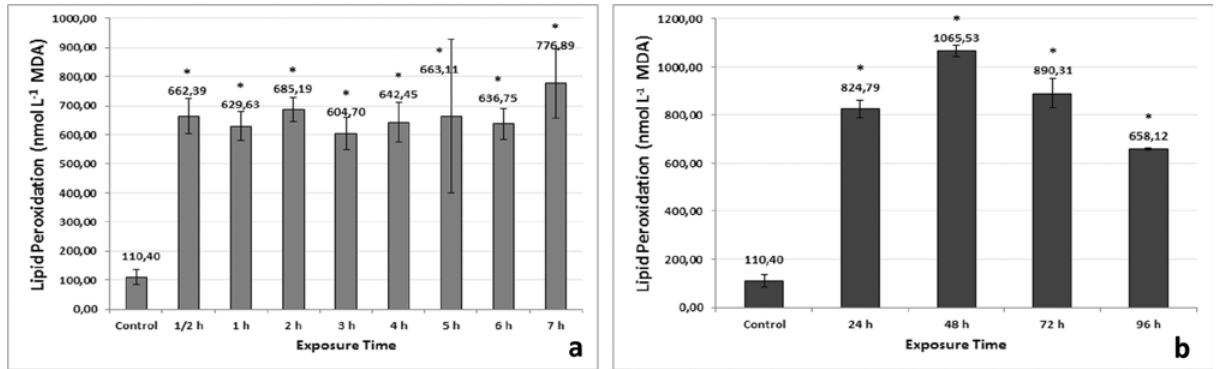
Figure 3. Lipid peroxidation of control and 100 µM AlCl 3 treated barley roots at short (a) and long (b) time points. The data with (*) are significantly different from the control at P < 0.05